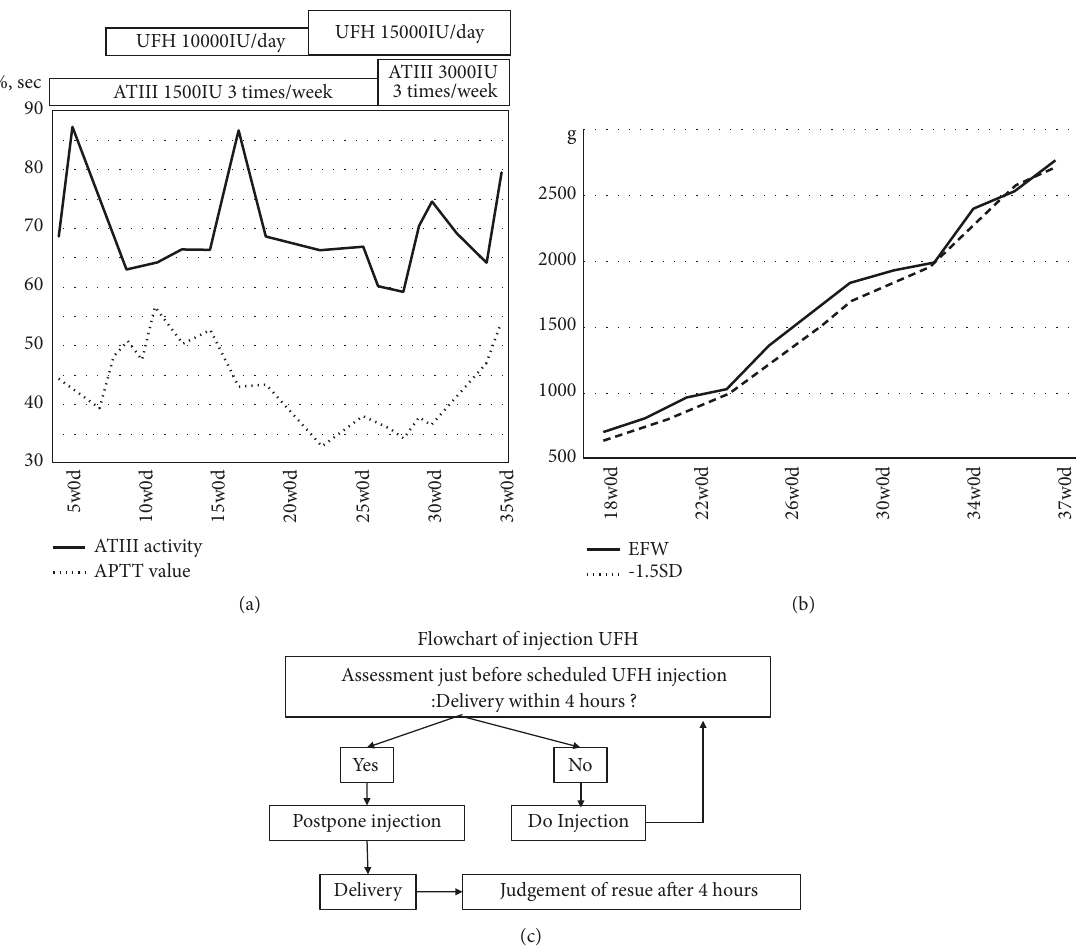
Figure 2: Clinical course in patient’s fifth pregnancy, and flow chart in delivery. (a) Treatment process and change of ATIII activity and APTT value during pregnancy. Y-axis; % (ATIII) and seconds (sec, APTT). (b) Change of the estimated fetal weight (EFW) of fetus. Dot line indicates the line of -1.5SD. (c) Flowchart that we considered at the delivery.